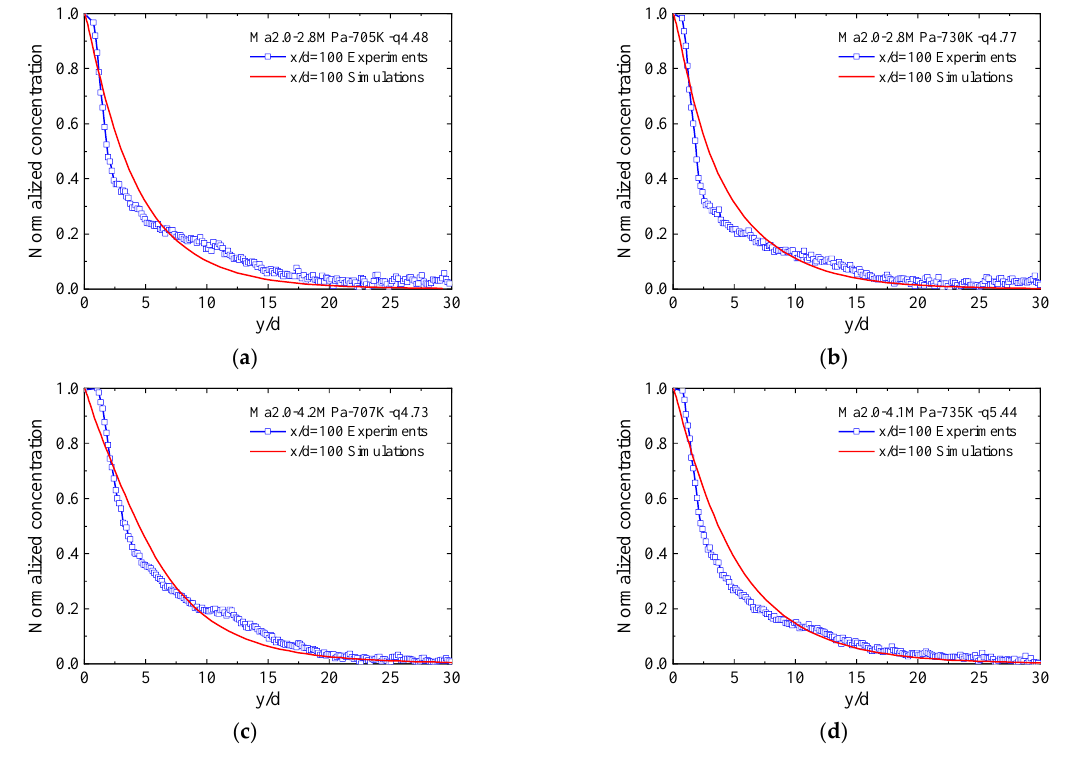
Figure 14. Comparison of concentration curves obtained by experiments and simulations. ( a ) Ma = 2.0, P j = 2.8 MPa, T j = 705 K. ( b ) Ma = 2.0, P j = 2.8 MPa, T j = 730 K. ( c ) Ma = 2.0, P j =4.2 MPa, T j = 707 K. ( d ) Ma = 2.0, P j = 4.1 MPa, T j = 735 K. Ma 2.0 (Tests 1-1, 1-2, 2-1, and 2-2). The curve data are extracted and normalized from the central concentration contour for the EHF plume at flow distances x/d of 100, 180, and 260. As can be seen, the highest concentration point starts from the near-wall region (x/d = 100) and rises in the y direction with the streamwise distance increasing (x/d = 180 and 260), which is in good agreement with the cross-sectional distribution. The relative values of the highest concentration points for x/d = 100 to 260 gradually decrease. x/d = 100 has a more variable concentration curve, indicating that most of the EHF components are confined within the limited space of the bottom wall, whereas the concentration curve for x/d = 260 tends to be smooth and flat. ( a ) ( b )